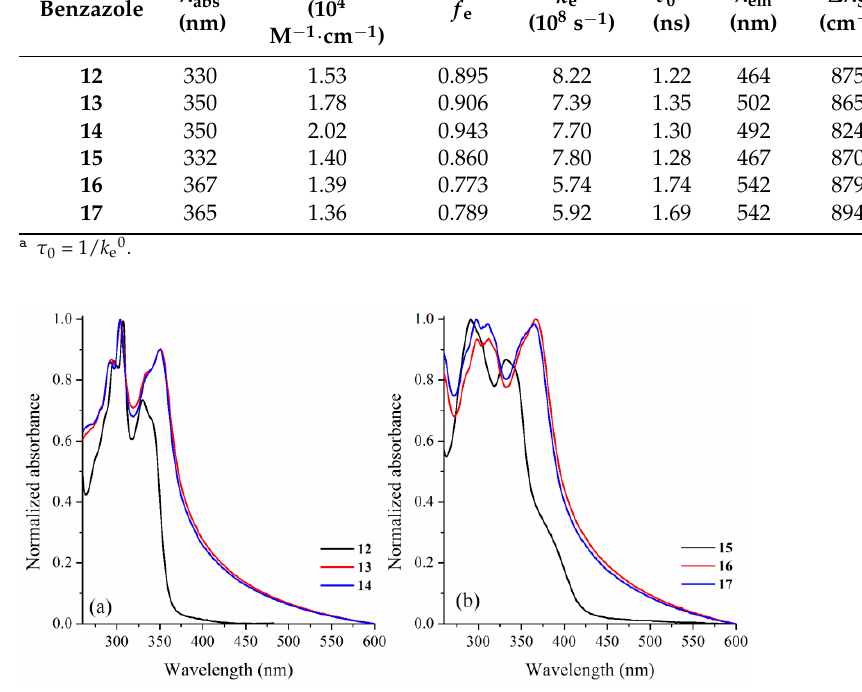
Figure 1. UV-Vis absorption spectra in PBS (pH 7.2) (approx. 10 − 5 M) of ESIPT fluorescent lipophilic (a) benzoxazoles 12–14 and (b) benzothiazoles 15 – 17 .